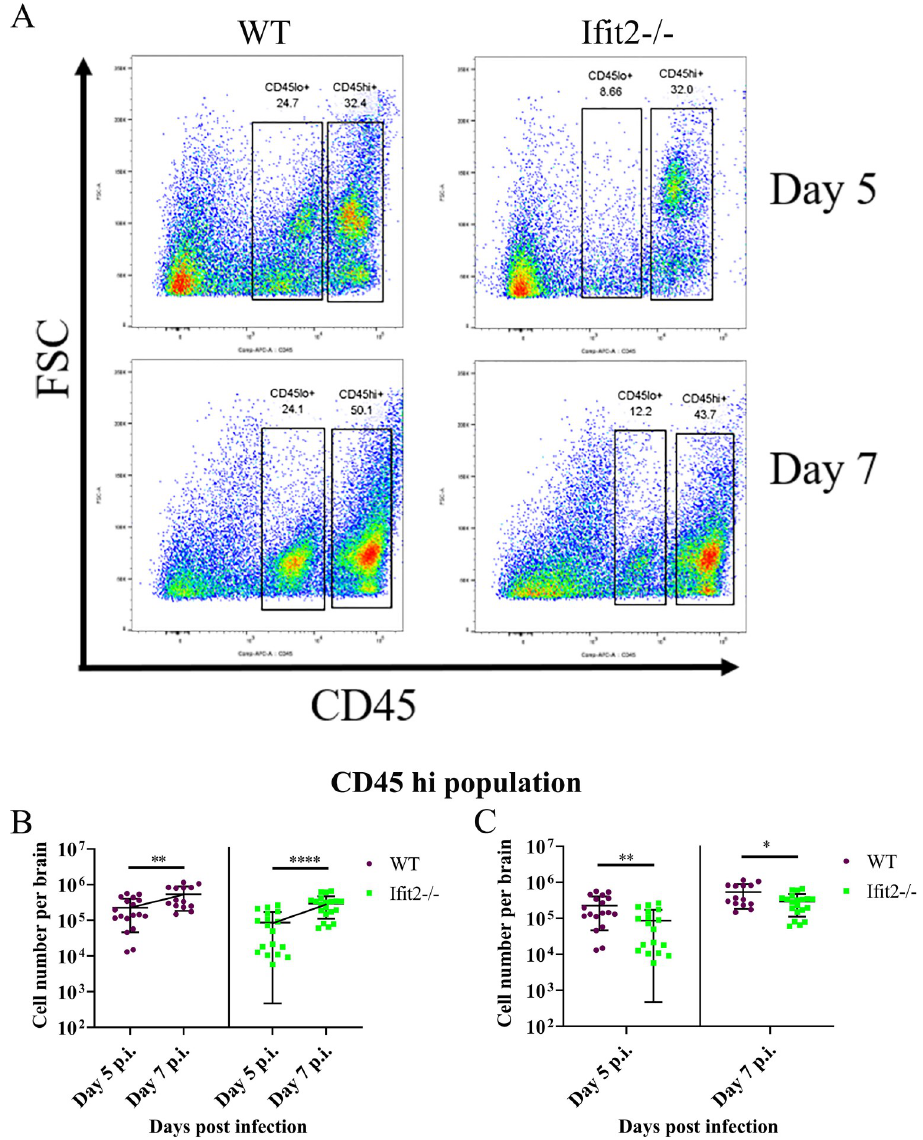
Fig 6. Ifit2 deficiency impairs CD45 + leukocyte migration into the CNS at day 5 and 7 post infection. Brains from WT and Ifit2 -/- mice infected with RSA59 were harvested at days 3, 5, and 7 p.i. for flowcytometric analysis. Purple colour denotes WT and green represents Ifit2 -/- mice. Panel A shows representative flow cytometry plots at day 5 and 7 p.i., indicating percentages of CD45 hi and CD45 lo cells in brains after gating on live cells. Absolute numbers of CD45 hi cells are graphically represented across timepoints (Panel B) and in between WT and Ifit2 -/- groups for day 5 p.i., and day 7 p.i. (Panel C) to better represent respective statistics. Graphs represent n = 14–20 mice from 3 separate experiments. Asterix ( � ) represents differences that are statistically significant by Student’s unpaired t-test analysis. ( � P < 0.05, �� P <